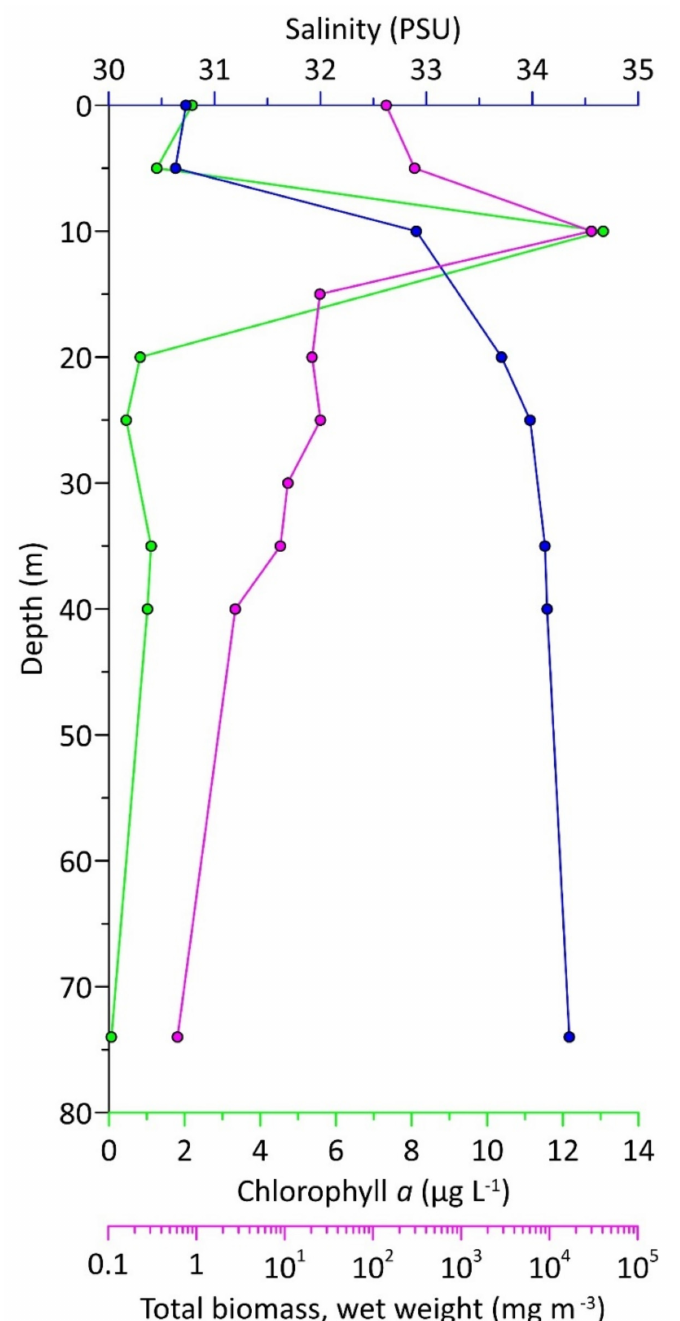
Figure 4. Change in salinity, chlorophyll, and wet weight biomass concentration with depth at station